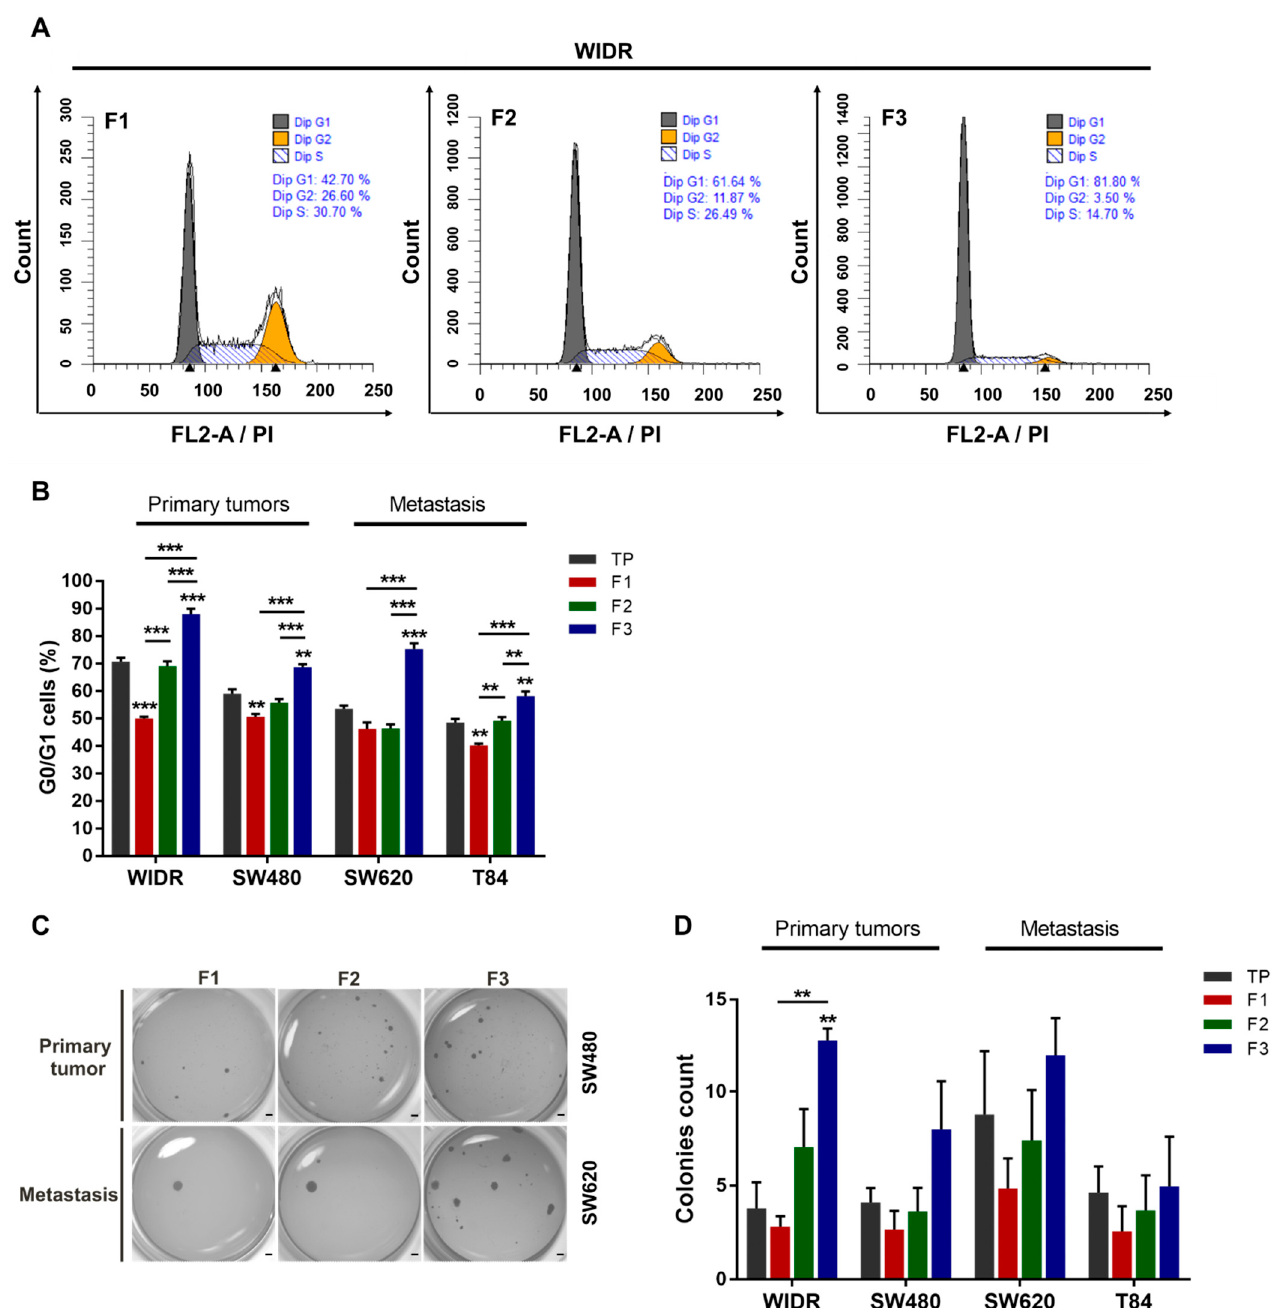
Figure 2. Functional characterization of SdFFF-sorted cell subpopulations from CRC cell lines highlighting a quiescent and clonogenic F3 subpopulation. ( A ) The distribution of the sorted cell subpopulations in the cell cycle was analyzed by flow cytometry and plotted as histograms using modfit software. Graphs show one representative biological replicate (n = 3). ( B ) Quantification of G0/G1 cells was performed for each sorted cell subpopulation and cell line, and presented in the bar plot from three biological replicates. ( C , D ) Cell clonogenicity was assessed by a soft agar assay. The results were presented as images of the wells with formed colonies ( C ) as well as the quantification of the colony count in the bar plot ( D ). Scale bar, 1 mm. All these results are represented as means ± SEM and statistical differences with ** p -value < 0.01, *** p -value < 0.001, and ** alone for significant results compared to TP using one-way ANOVA test for cell cycle distribution analysis and Kruskal–Wallis test for clonogenicity.